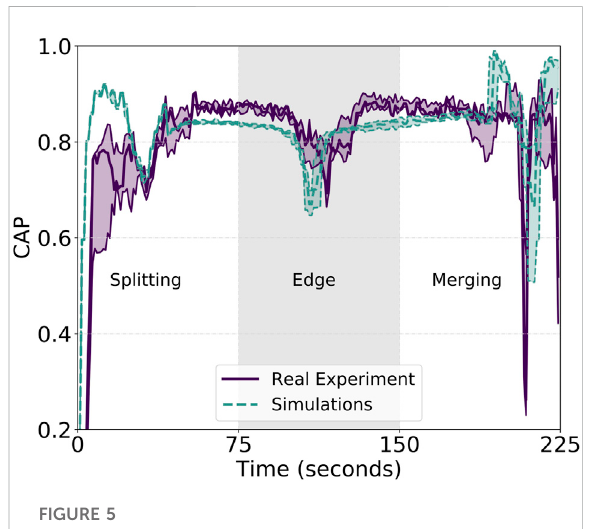
FIGURE 5 Reported CAP metric for the simulated and real experiments with communication. Higher y-values show better CAP performance. The metric is not computed for the whole experiments but only from the start until the group reaches the merging phase at roughly 400 m from the starting position. The last straight returning phase after the merging does not provide additional information and is left out for the sake of